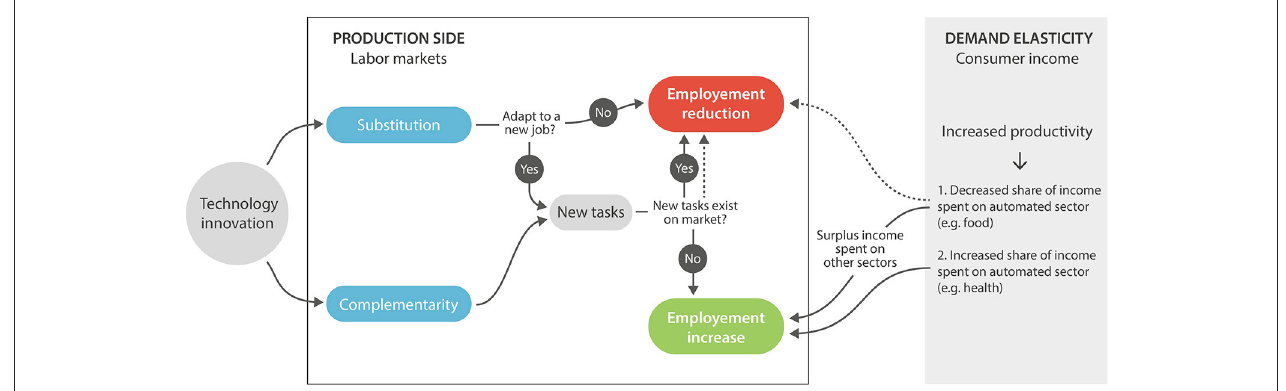
FIGURE 1 | Technological innovations’ impact on employment from production- and demand-side perspectives (left- and right-hand side, respectively). The figure is based on a qualitative analysis in Autor (30). Automation’s impact is complex and can lead to both employment reduction (top middle) and increased employment (bottom middle) via creating of new economic niches or strengthening existing ones. Automation can substitute jobs (upper left) and result in unemployment unless the replaced workers learn a new job skill. In many cases automation and skilled labor can complement (lower left) increasing production and efficiency. New tasks can increase the amount of employment (arrow going down) or reduce it (arrow going up) depending on whether or not they are available elsewhere in the economy. New employment opportunities due to automation that are not available elsewhere (new niche markets) might not offset the loss of jobs replaced, resulting in overall reduction in employment (dashed arrow on the left going up). Automation can potentially increase efficiency and reduce economic expenditures, therefore reducing consumer demand and subsequently employment (dashed arrow on right-hand side), but overall household demand in goods and services has only increased in the long run, enlarging the economy and creating jobs. In some cases automation has increased household expenditure (demand) on certain sectors (e.g., health), which increase employment in that sector. Despite the complexity of the pathways detailed above that can potentially lead to increased employment or unemployment, historically aggregated employment has generally risen despite large changes in type and quality